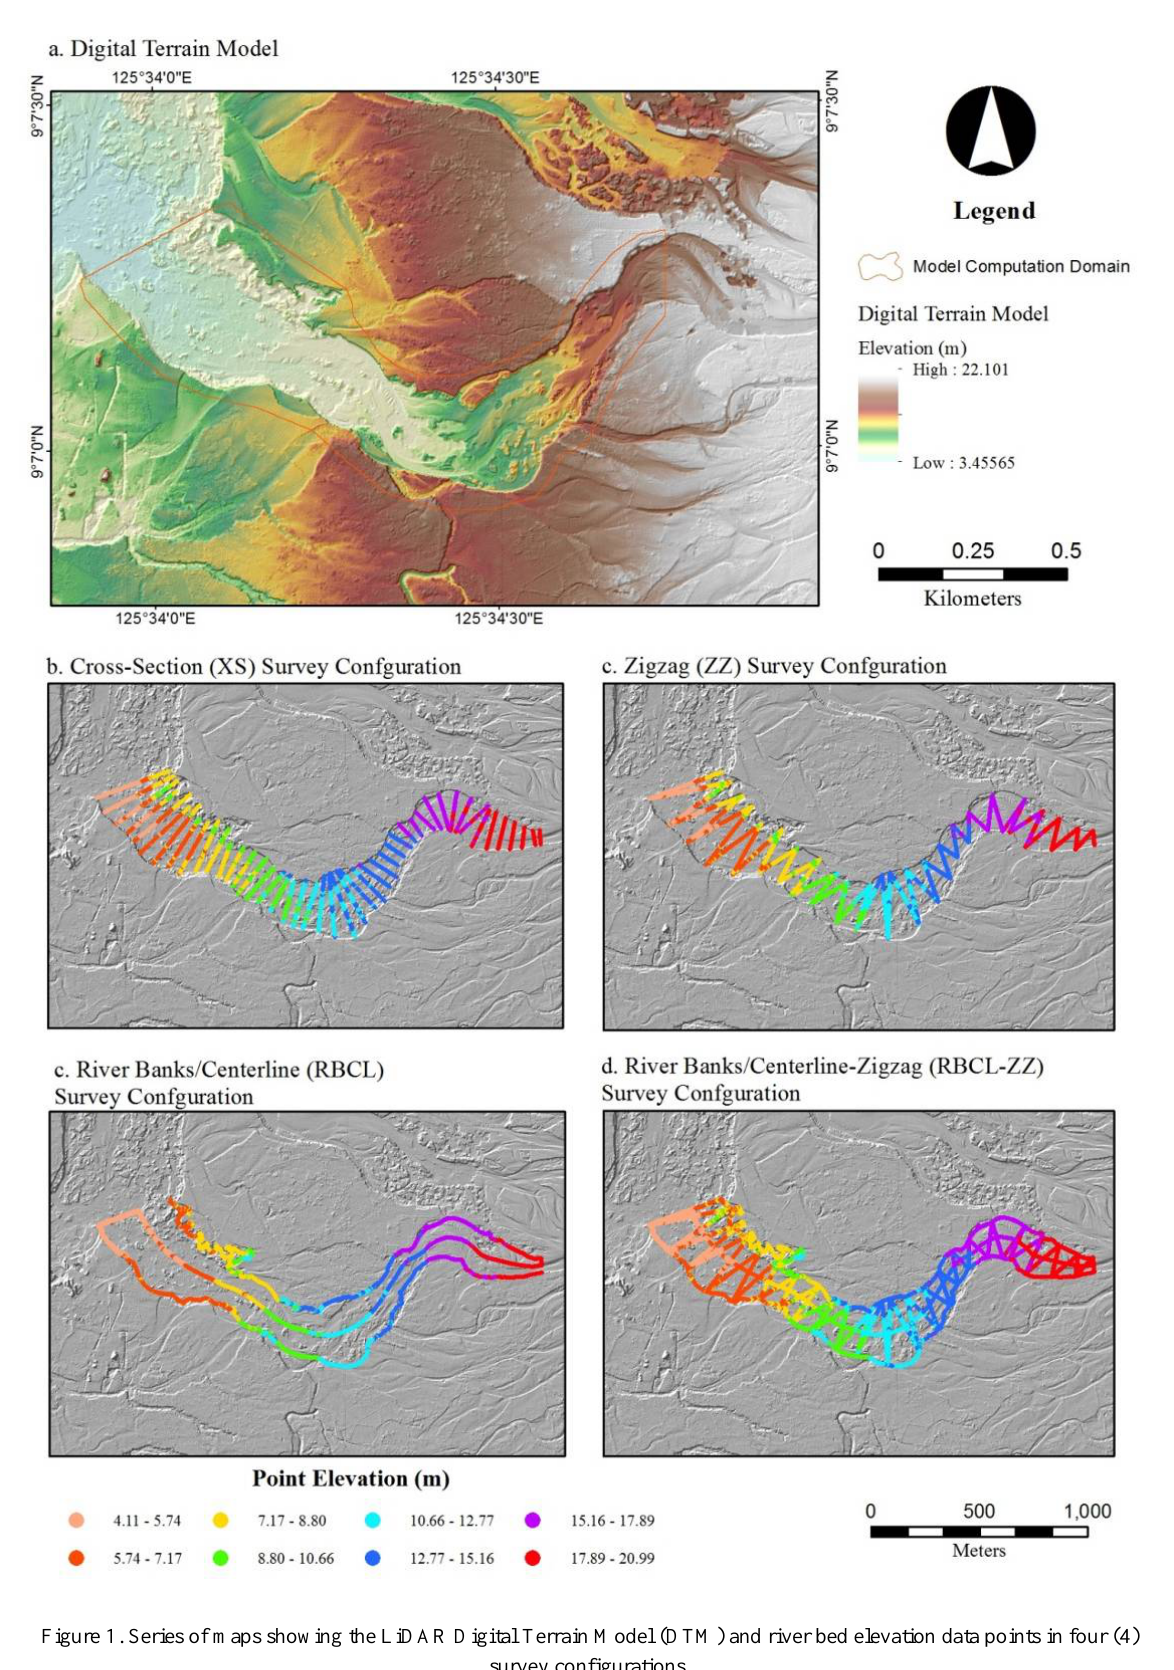
Figure 1. Series of maps showing the LiDAR Digital Terrain Model (DTM) and river bed elevation data points in four (4) survey